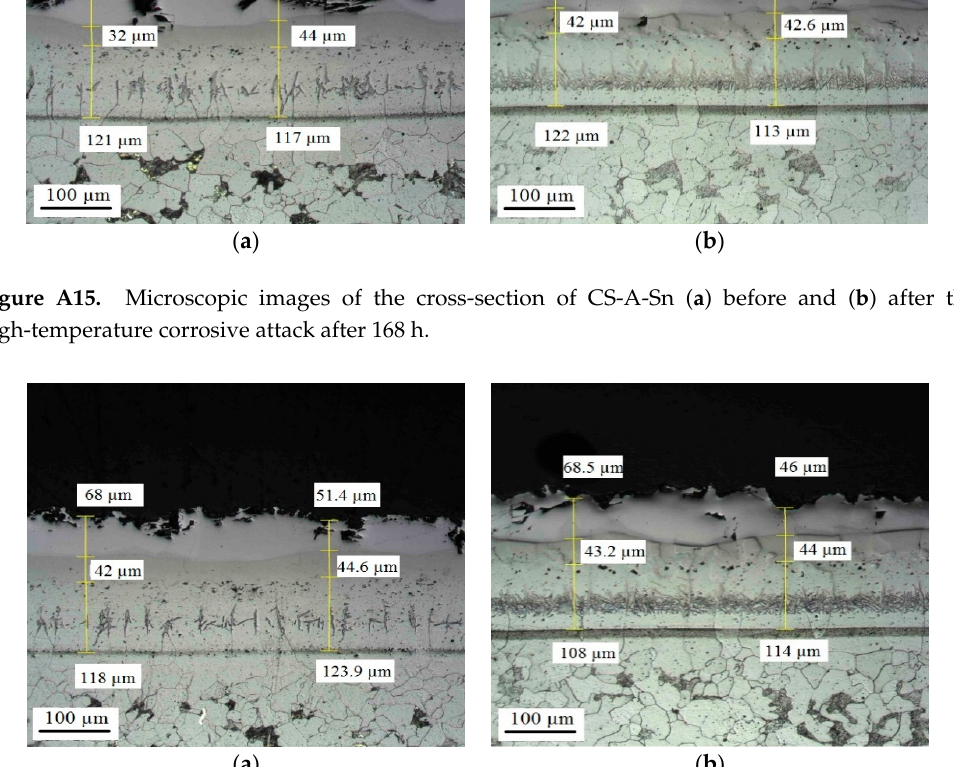
Figure A16. Microscopic images of the cross-section of CS-A-Z ( a ) before and ( b ) after the high-temperature corrosive attack after 168 h.